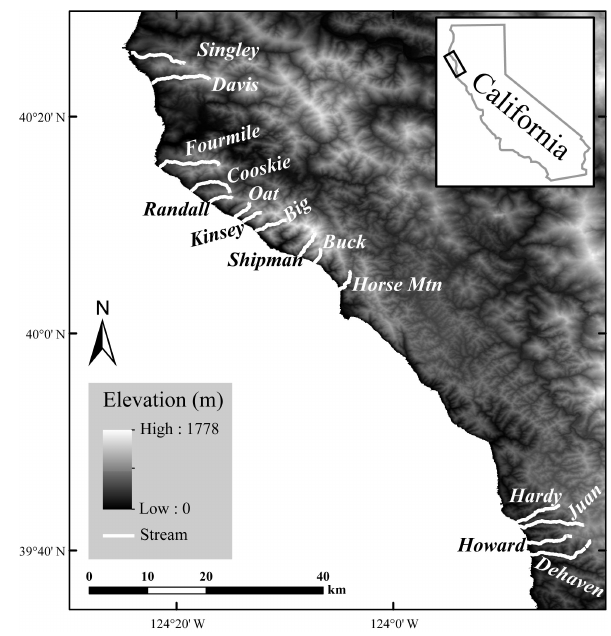
Figure 2. Streams in the Mendocino Triple Junction (MTJ) re- gion of northern California, USA. Streams are from Snyder et al. (2000). The elevation data are from a 1arcsec SRTM DEM